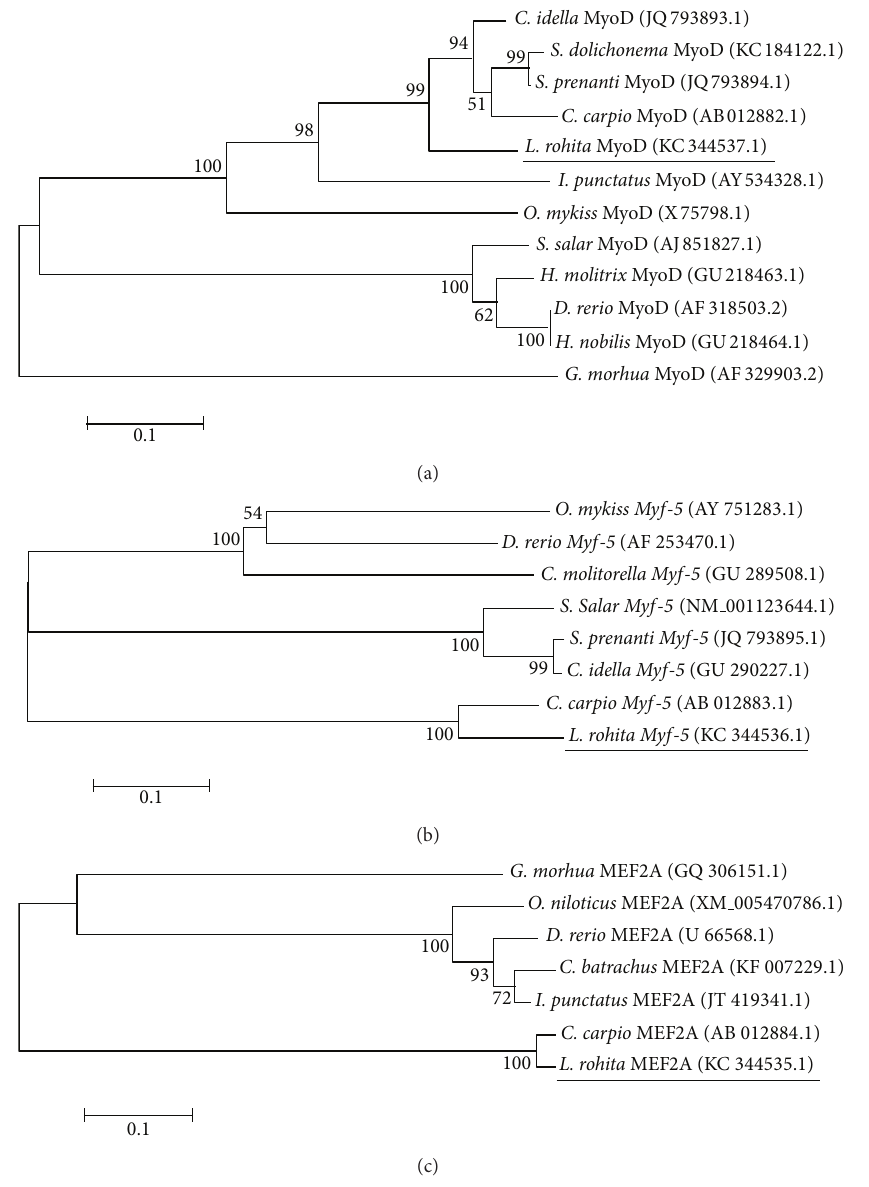
Indian carp describing monthly expression pattern of these transcription factors in juvenile and adult Labeo rohita